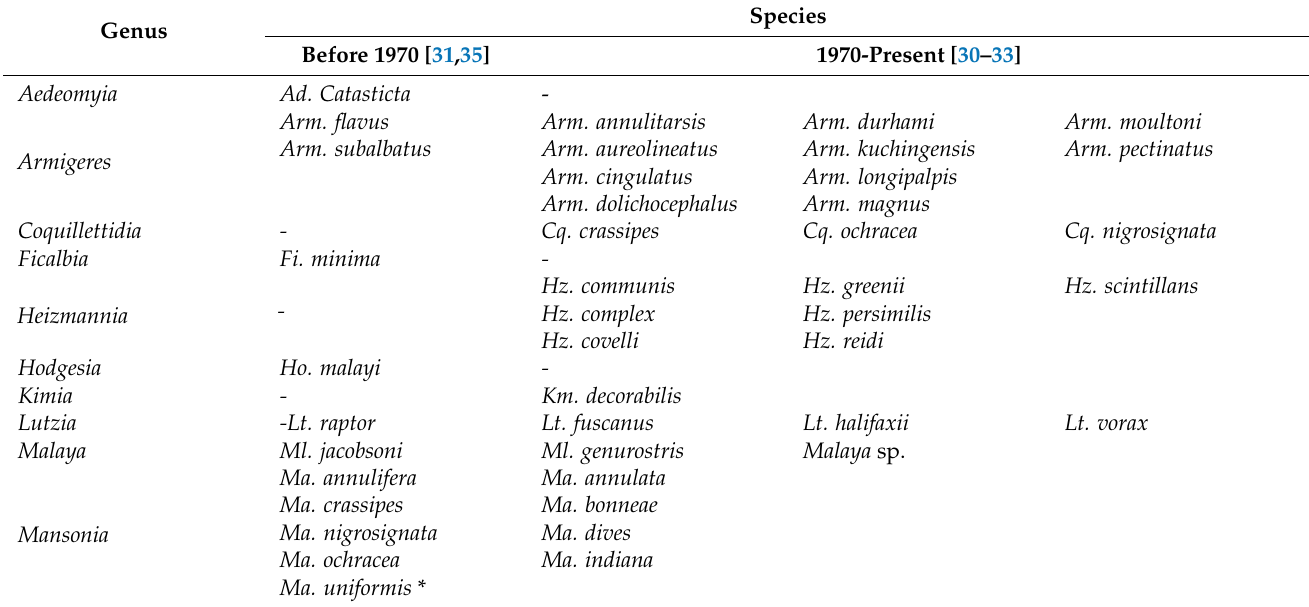
Table 2. Checklist of mosquito species reported in Vietnam, excluding the genera of Anopheles , Aedes , and Culex